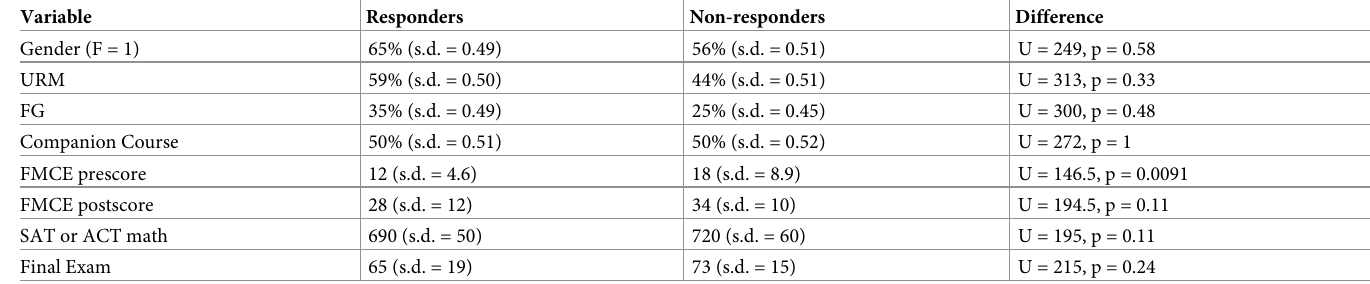
Table 1. Descriptive statistics for students who did and did not respond to requests for interviews. Differences were tested by the Mann-Whitney U-test, and p-values have not been corrected for multiple comparisons.